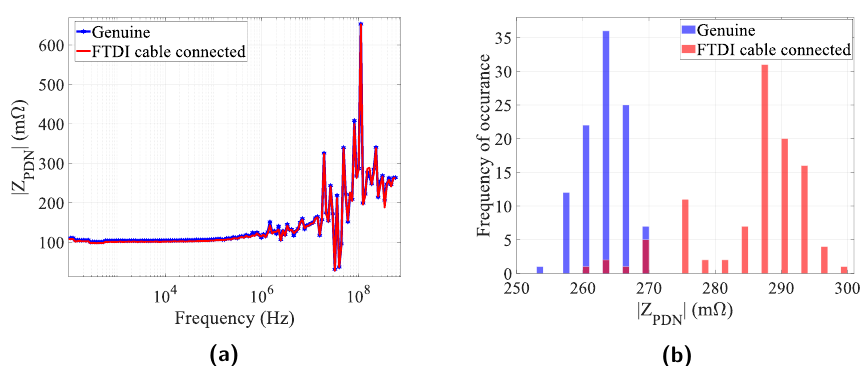
Figure 14: Connecting the FTDI cable to one of the I/O ports. (a) The mean of 105 impedance profile signatures. (b) Histogram representation ( f = 169 . 85